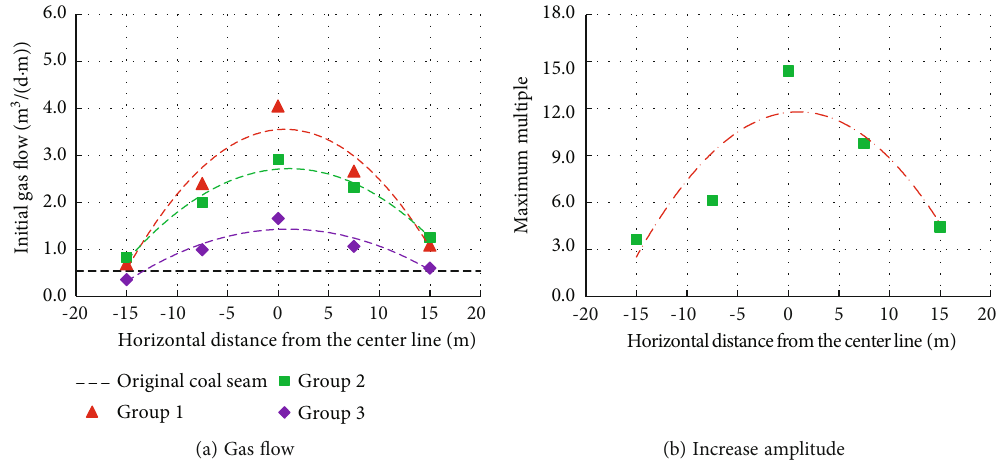
Figure 21: Change curve chart of initial gas fl ow in drill holes in 213 fl oor roadway of Qujiang Coal